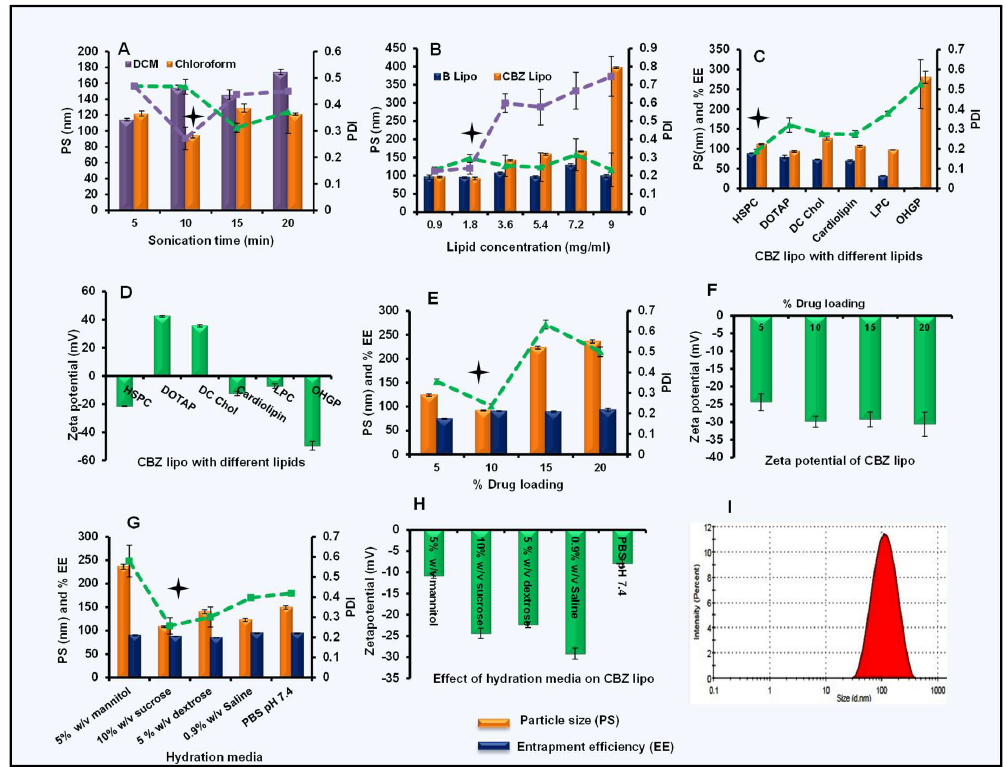
Figure 1. Preparation and optimization of cabazitaxel (CBZ) liposomes: (A ) Effect of solvents on particle size and polydispersity index (PDI) of blank liposomes, ( B ) effect of lipid concentration on blank and CBZ liposomes, ( C ) effect of type of lipid on CBZ liposomes, ( D ) zeta potential of CBZ liposomes with different lipids, ( E ) effect of drug loading on PS, PDI, and percentage of entrapment efficiency (% EE), ( F ) zeta potential at varied drug loading, ( G ) effect of hydration media on CBZ liposomes, ( H ) zeta potential of CBZ liposomes with different hydration media, and ( I ) particle size distribution for optimized CBZ liposomes. Data was represented in mean ± SD.